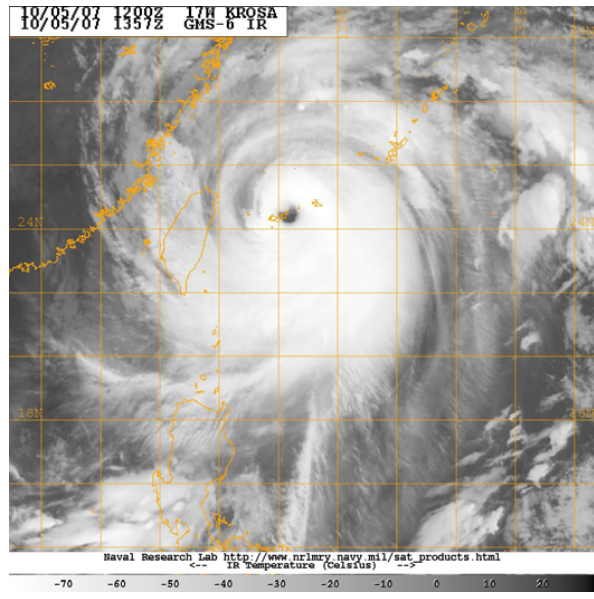
Figure 1. Typhoon Krosa approaching Taiwan. Fig. 1. Typhoon Krosa approaching Taiwan.